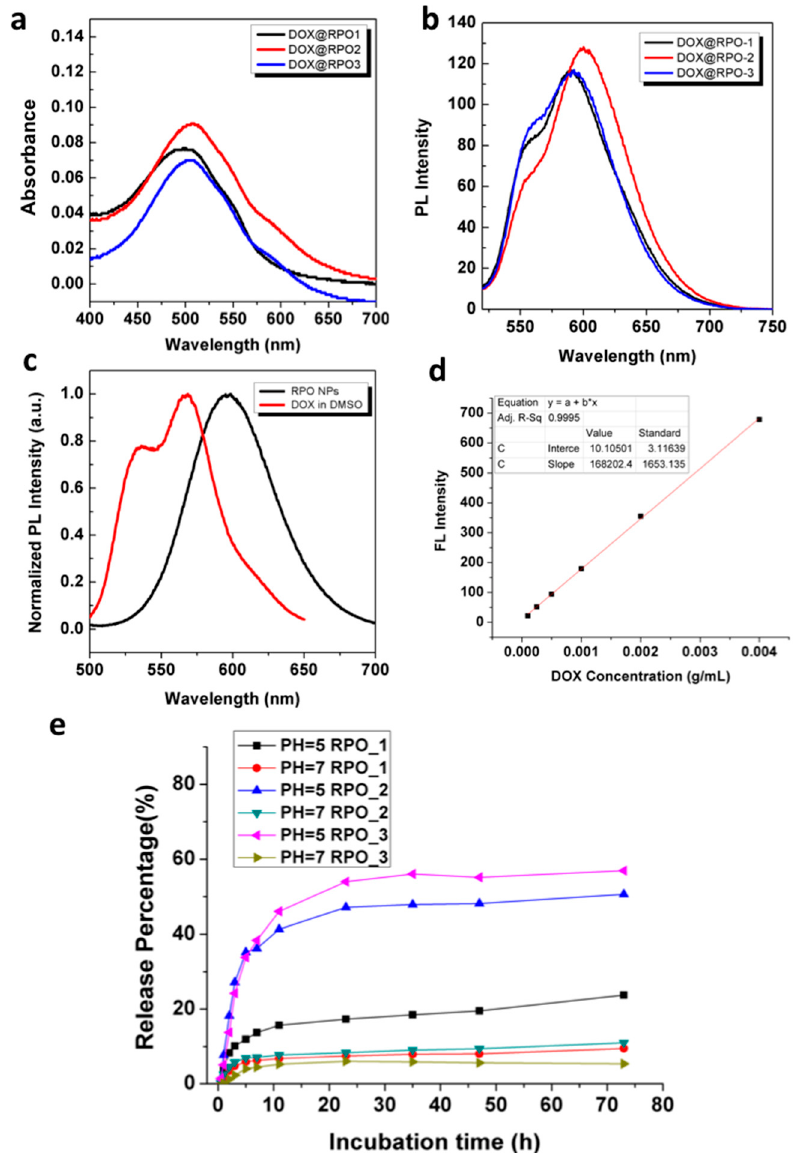
Figure 3. ( a , b ) UV–vis absorption ( a ) and fluorescence emission ( b ) spectra of RPO polymers with doxorubicin (DOX) encapsulated. ( c ) Fluorescence emission spectra of DOX in DMSO and RPO nanoparticles (NPs) in water excited at 488 nm. ( d ) Calibration curve of DOX concentration vs. fluorescence intensity at 550 nm. ( e ) Release profile of DOX@RPO within 3 days in pH = 5.0 or 7.4 aqueous solution incubated at 37 °C (C DOX = 50 µg mL − 1 ).